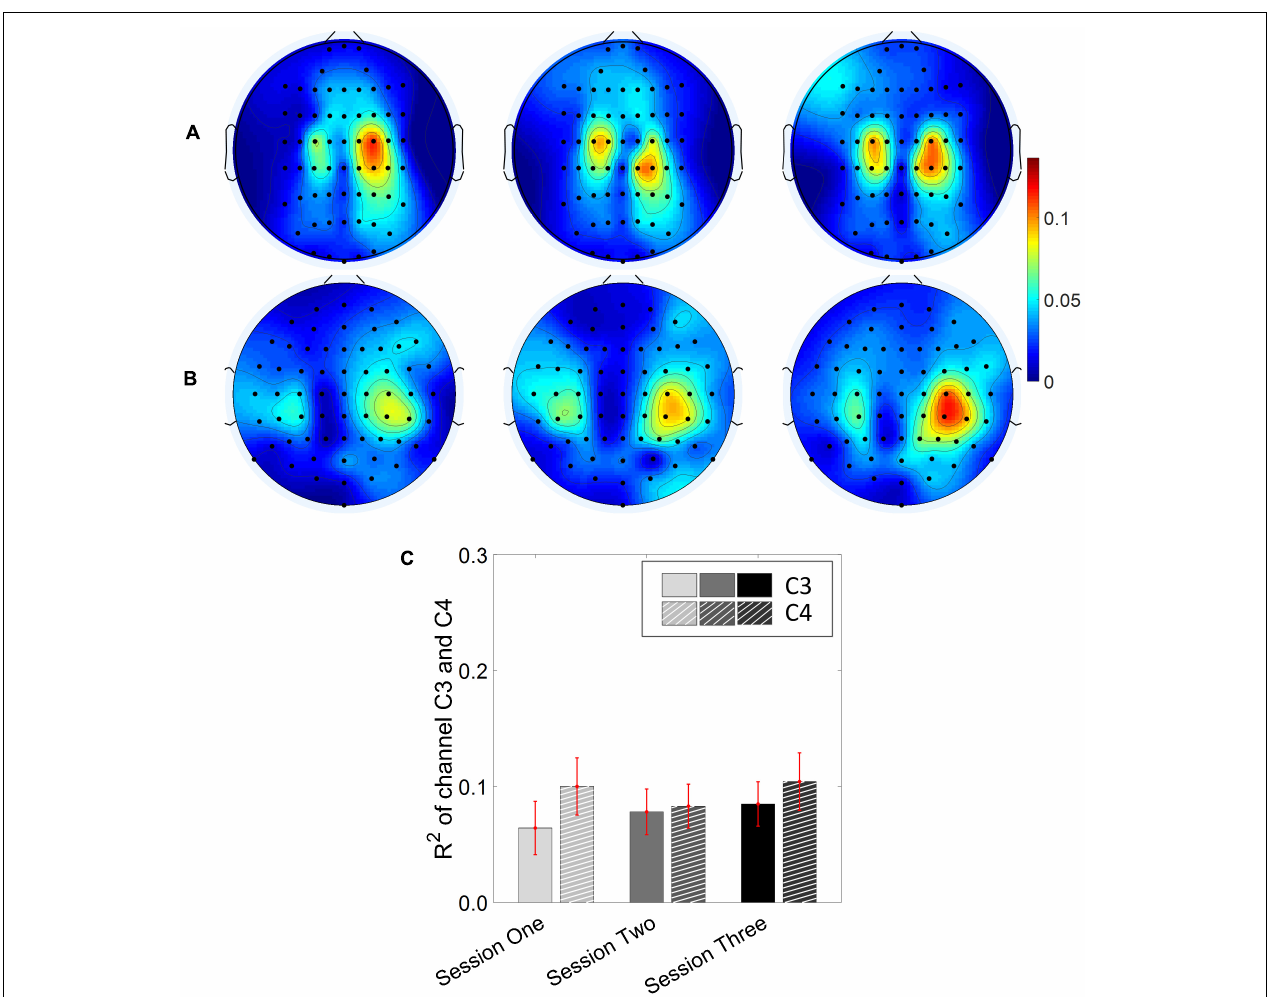
FIGURE 3 | R 2 value topography maps and its statistics. All of the trials are used for the calculation of R 2 values. (A) Topography of group average R 2 value across the three training sessions for subjects using Neuroscan SynAmps RT acquisition system ( N = 28). (B) Topography of group average R 2 value across the three training sessions for subjects using Biosemi Active Two acquisition system ( N = 14). (C) R 2 value of channel C3 and C4 across the three training sessions. The statistical analysis revealed no significant difference of R 2 value between channel C3 and C4 on the three training